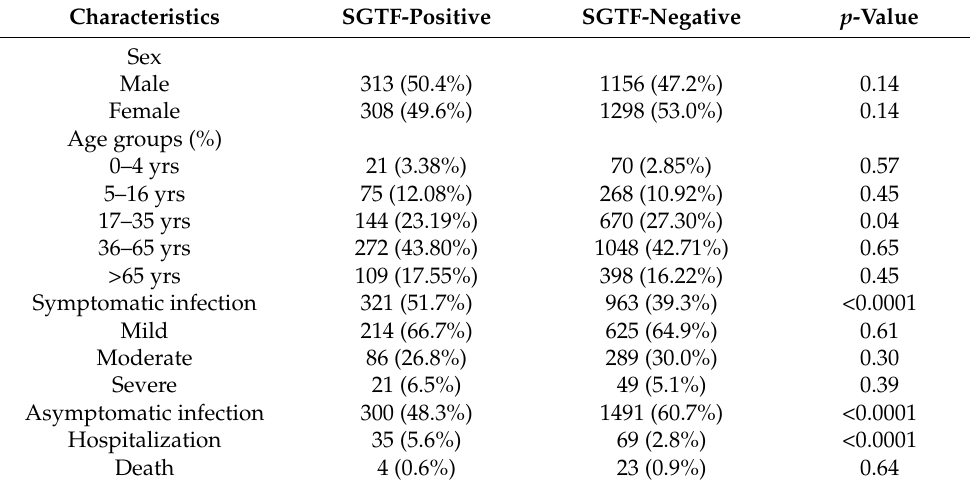
Figure 1. Distribution (%) of S gene target failure (SGTF)-positive cases among new SARS-CoV-2 infections identified from week 52/2020 to week 10/2021 in the Apulia region of Italy, and SARS-CoV-2 strains confirmed as VOC 202012/01-B.1.1.7 lineage by whole genome sequencing, by week. Table 1. Demographic and clinical characteristics of SGTF-positive and SGTF-negative cases identi- fied from week 52/2020 to week 10/2021 in the Apulia region of